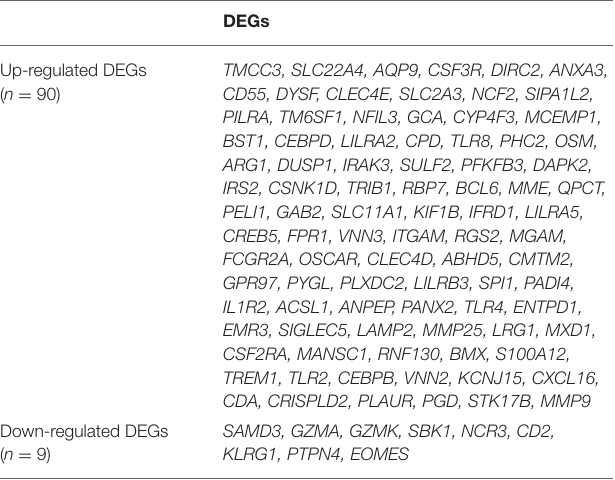
TABLE 1 | The DEGs convergence in GSE60093, GSE61144, and GSE66360 in the comparison of STEMI patients with healthy